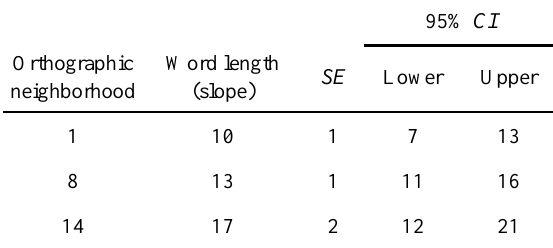
Table A3. Gaze duration: Interaction of word length and orthographic-neighborhood size.